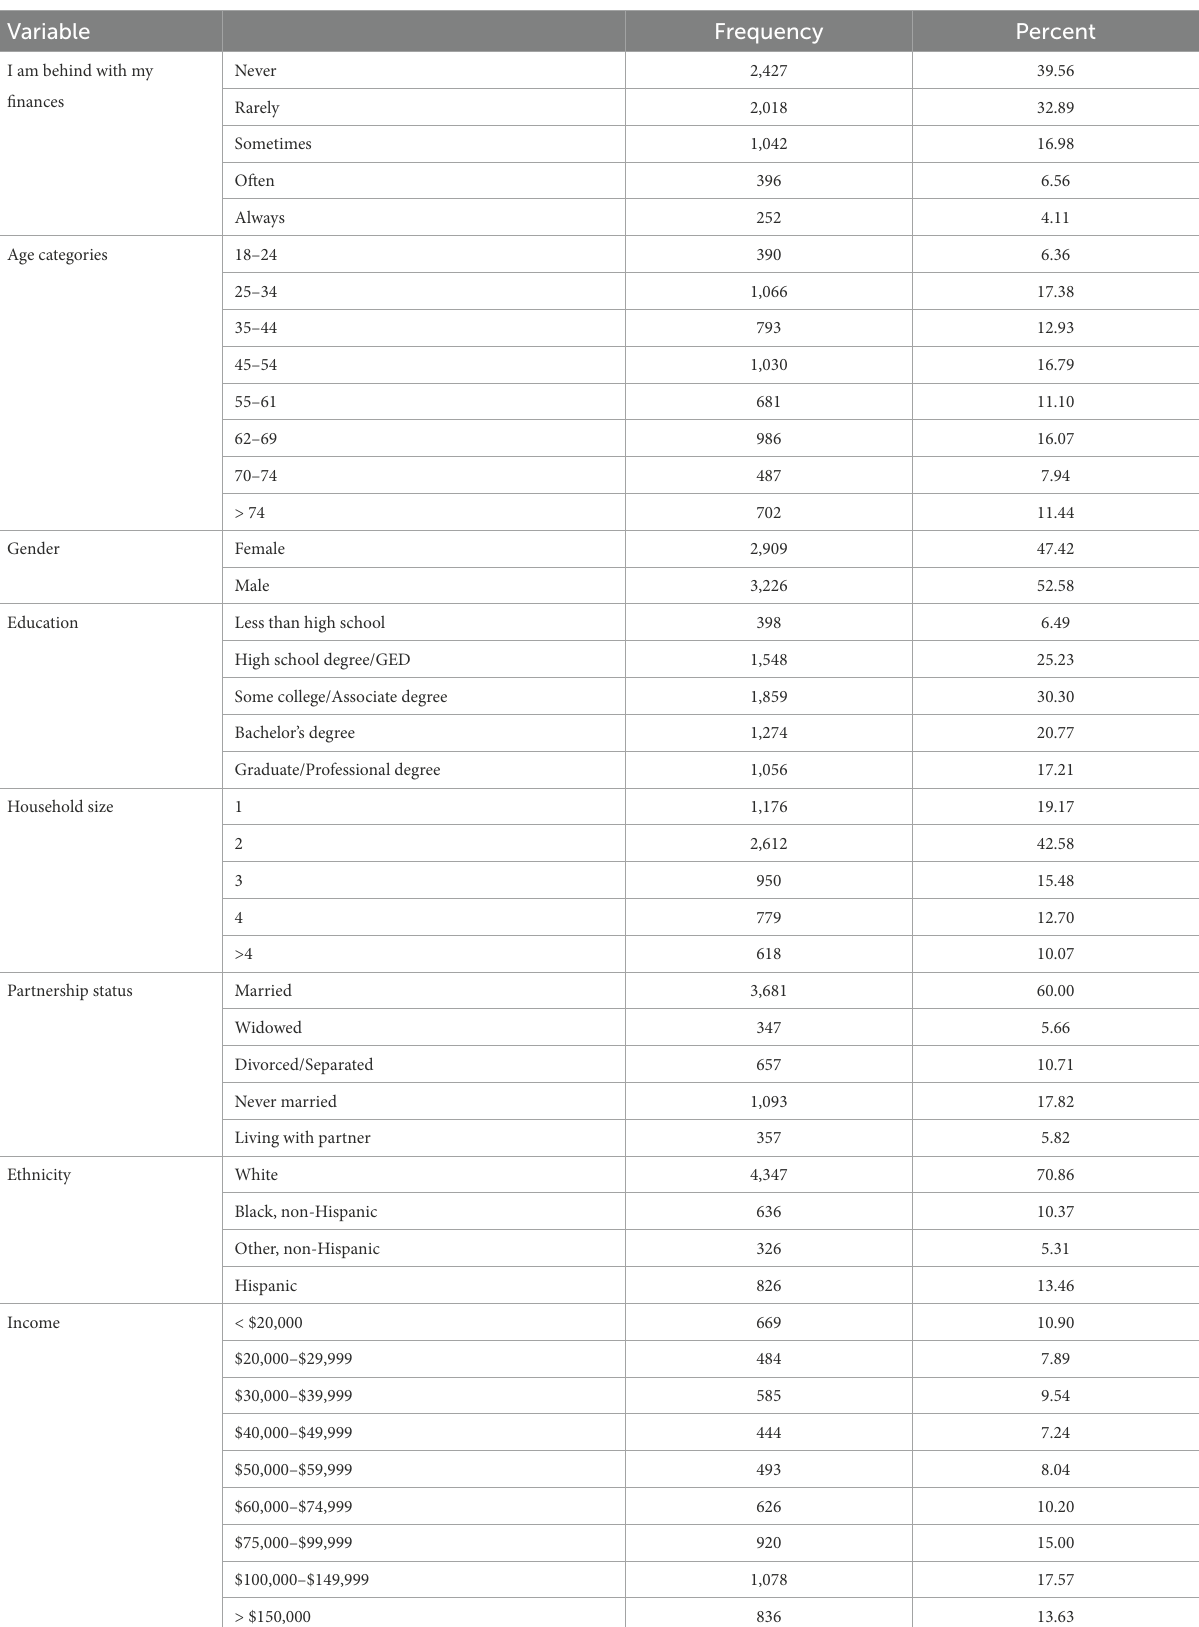
TABLE 1 Frequency distribution of the categorical